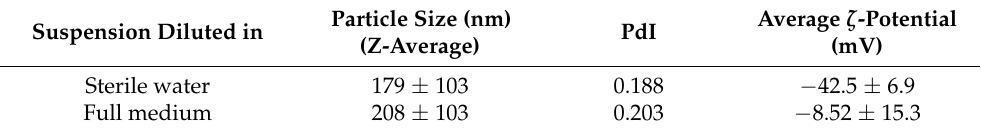
Table 1. Physical properties of GP1. Suspension Diluted